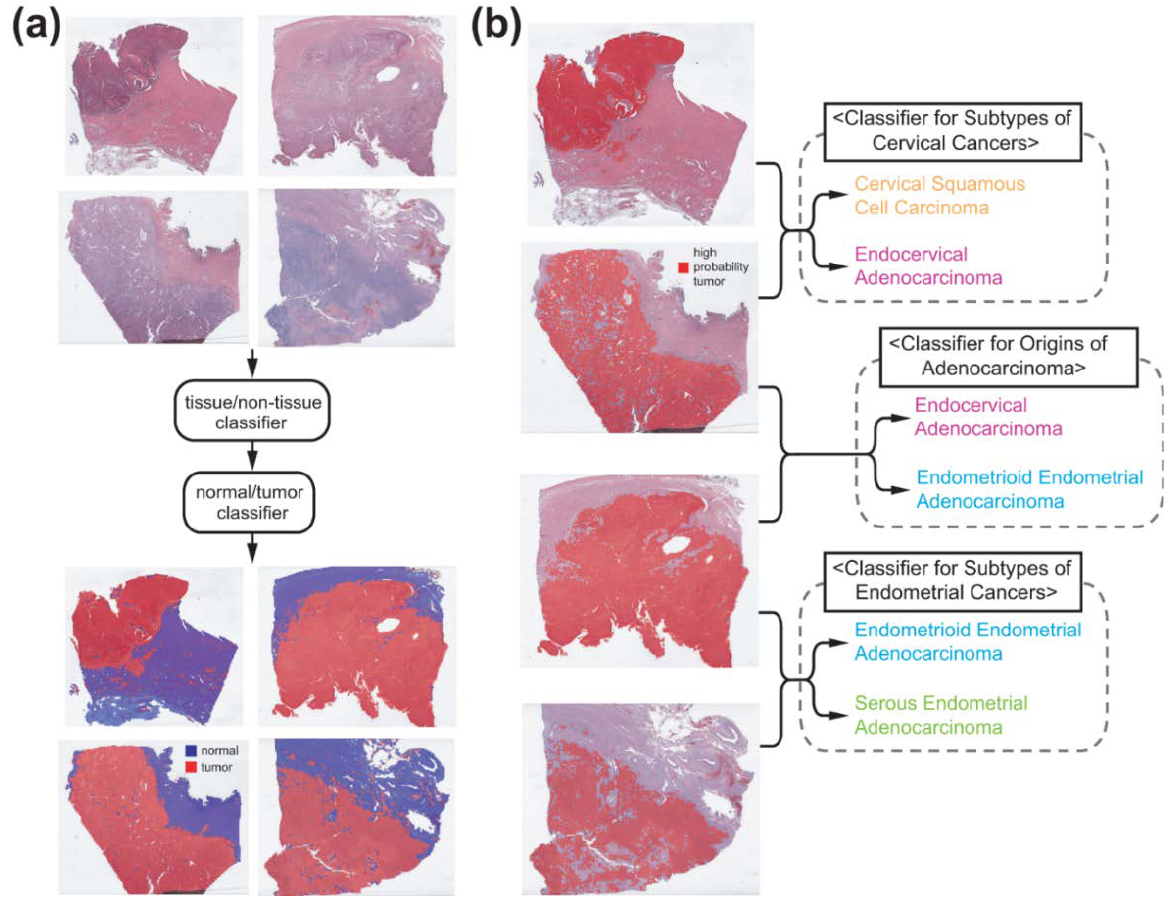
Figure 1. Classification procedure. ( a ) Sequential application of tissue/non-tissue and normal/tumor classifiers can discriminate proper tumor tissues. ( b ) Three separate classifiers for subtypes of cervical cancers, subtypes of endometrial cancers, and site of origin for adenocarcinomas were trained from tumor tissue image patches.